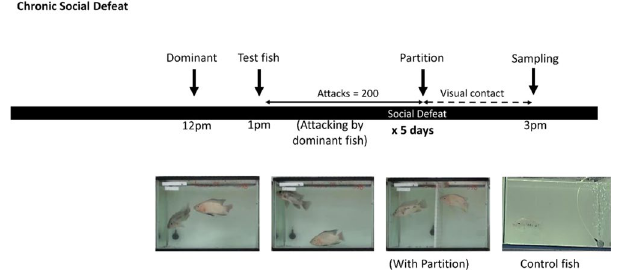
Figure 1. Social Defeat experiment paradigm. For chronic social defeat, the test fish was exposed to social defeat stress for 2 hours daily for 5 consecutive days. Sampling for defeated and control fish was done at the same timing at the 5 th day. Control group was exposed to the same protocol with the absence of the dominant